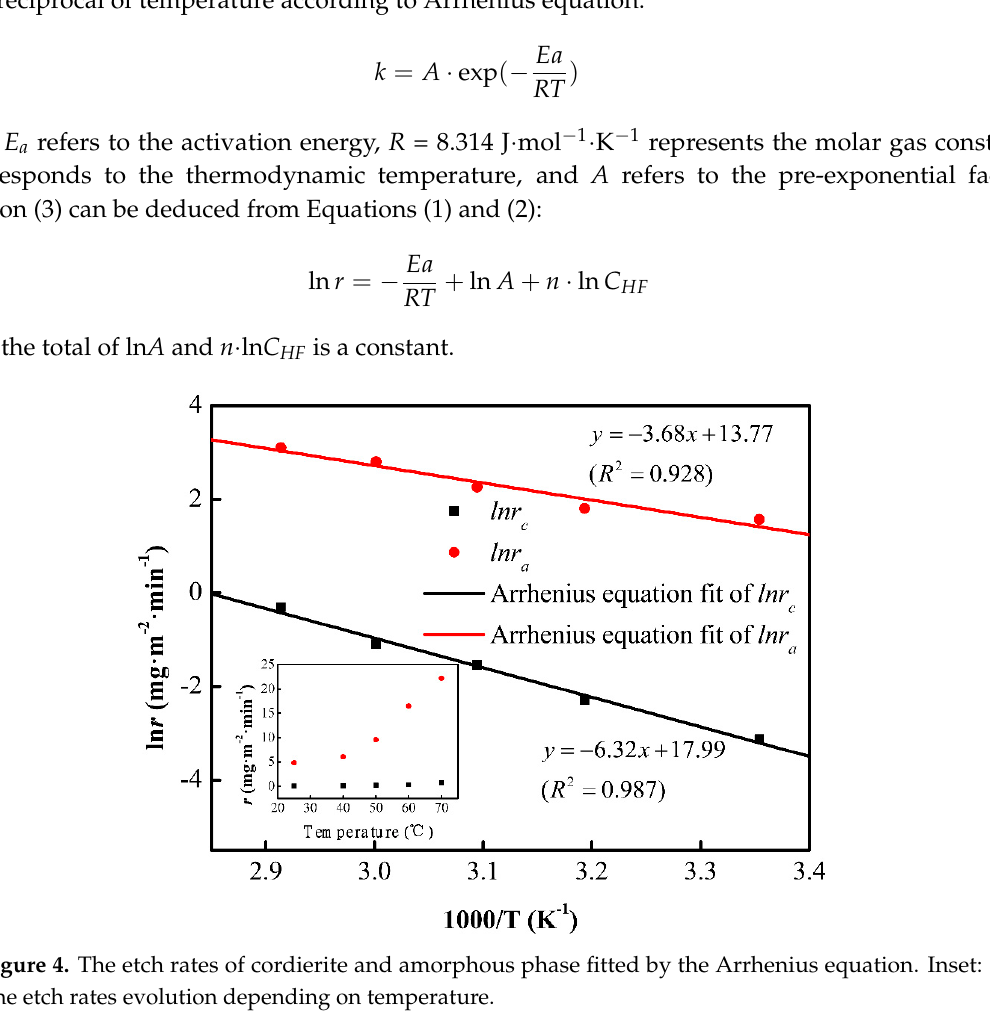
( b ) Figure 5. Two-dimensional diagram of different Mg 2+ connection in ( a ) cordierite (triangles with lines inside represent [SiO 4 ] and [AlO 4 ] tetrahedrons) and ( b ) the amorphous phase (The Si–O bond perpendicular to the paper is not shown for watching convenience).